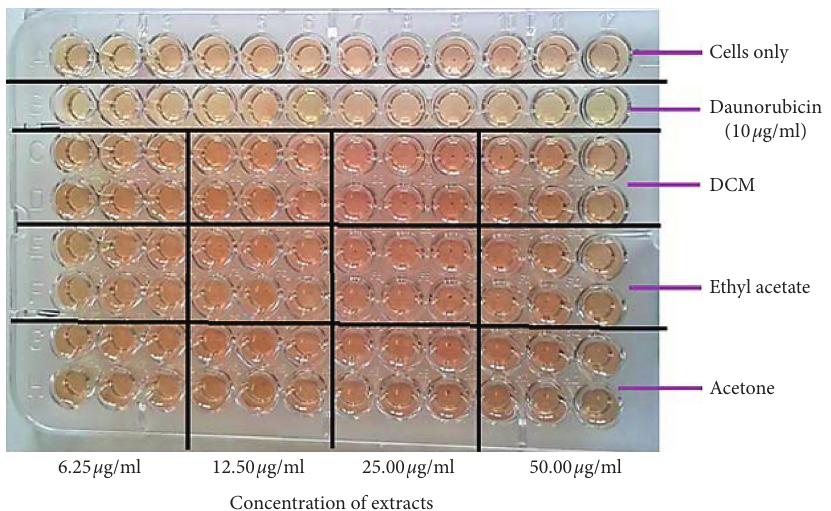
Figure 6: Image showing a 96-well plate for the MTT assay using mouse peritoneal cells, exposed to different solvent extracts from P. curatellifolia leaves (black dots in the wells indicate purple-coloured peritoneal cells that have sedimented at the bottom of the well). Cells only in row were the negative control, while the positive control was daunorubicin 10 μ g/ml, a standard anticancer